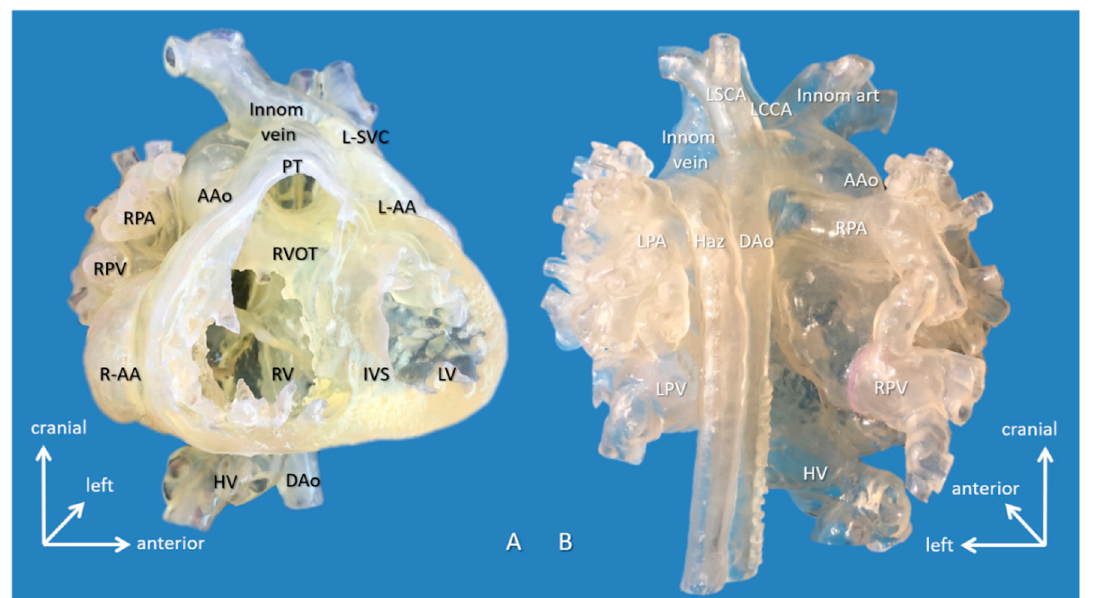
Figure 2. 3D-printed hollow model of right atrial isomerism, visceral heterotaxy, dextrocardia, common atrium, and hemiazygos continuity to left superior vena cava (Case 11). ( A ) Right anterior oblique view with the ventricular apex removed. Innominate vein and the interrupted inferior vena cava connected by the hemiayzgos vein drain into left-sided atrium via left superior vena cava. The hepatic veins also drain to the left-sided atrium. ( B ) Posterior view. Abbreviations: AAo: ascending aorta, DAo: descending aorta, Haz: hemiazygos vein, HV: hepatic vein, innom art/vein: innominate artery and vein, IVS: interventricular septum, L-AA: left-sided morphologically right atrial appendage, LCCA: left common carotid artery, LPA: left pulmonary artery, LPV: left pulmonary vein, LSCA: left subclavian artery, L-SVC: left superior vena cava, LV: left ventricle, PT: pulmonary trunk, R-AA: right-sided morphologically right atrial appendage, RPA: right pulmonary artery, RPV: right pulmonary vein, RV: right ventricle.